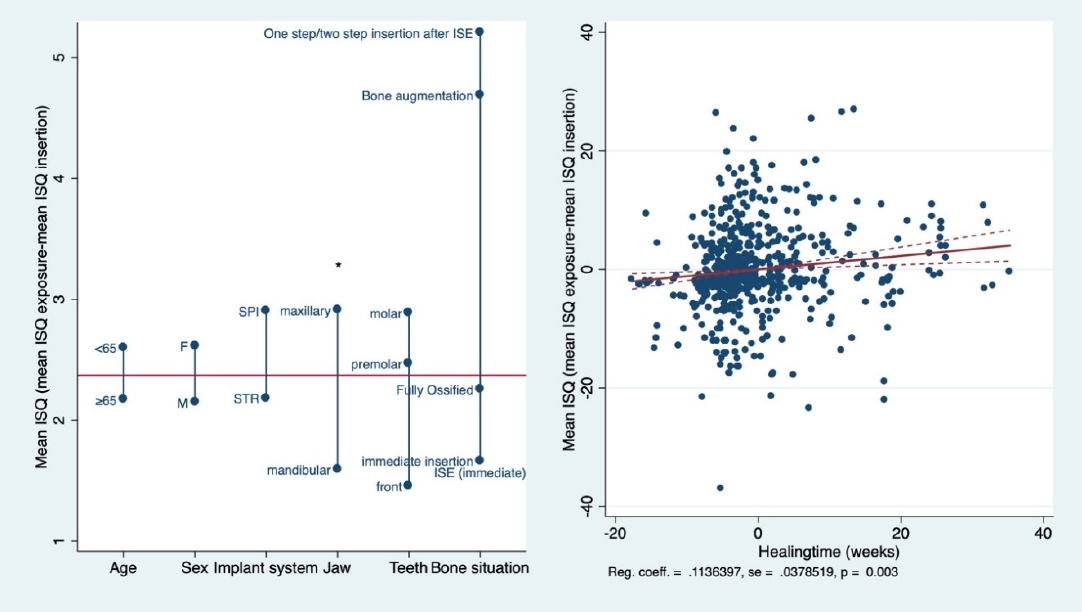
Figure 6. Illustration of changes in ISQ between primary (implant insertion) and secondary (implant exposure) RFA measurements, grouped by predictive factors (left). Implant localization (maxillary vs. mandibular) showed statistical significance in the pairwise analysis (* p < 0.05). However, healing time (in weeks) was the only predictive factor to show statistical significance in the multivariable linear mixed regression model when adjusted for other study variables (right). STR: Straumann implants. SPI: Thommen implants. ISQ: implant stability quotient. ISE: internal sinus elevation. F: female. M: male. Reg. coeff.: regression coefficient. se: standard error of the mean.